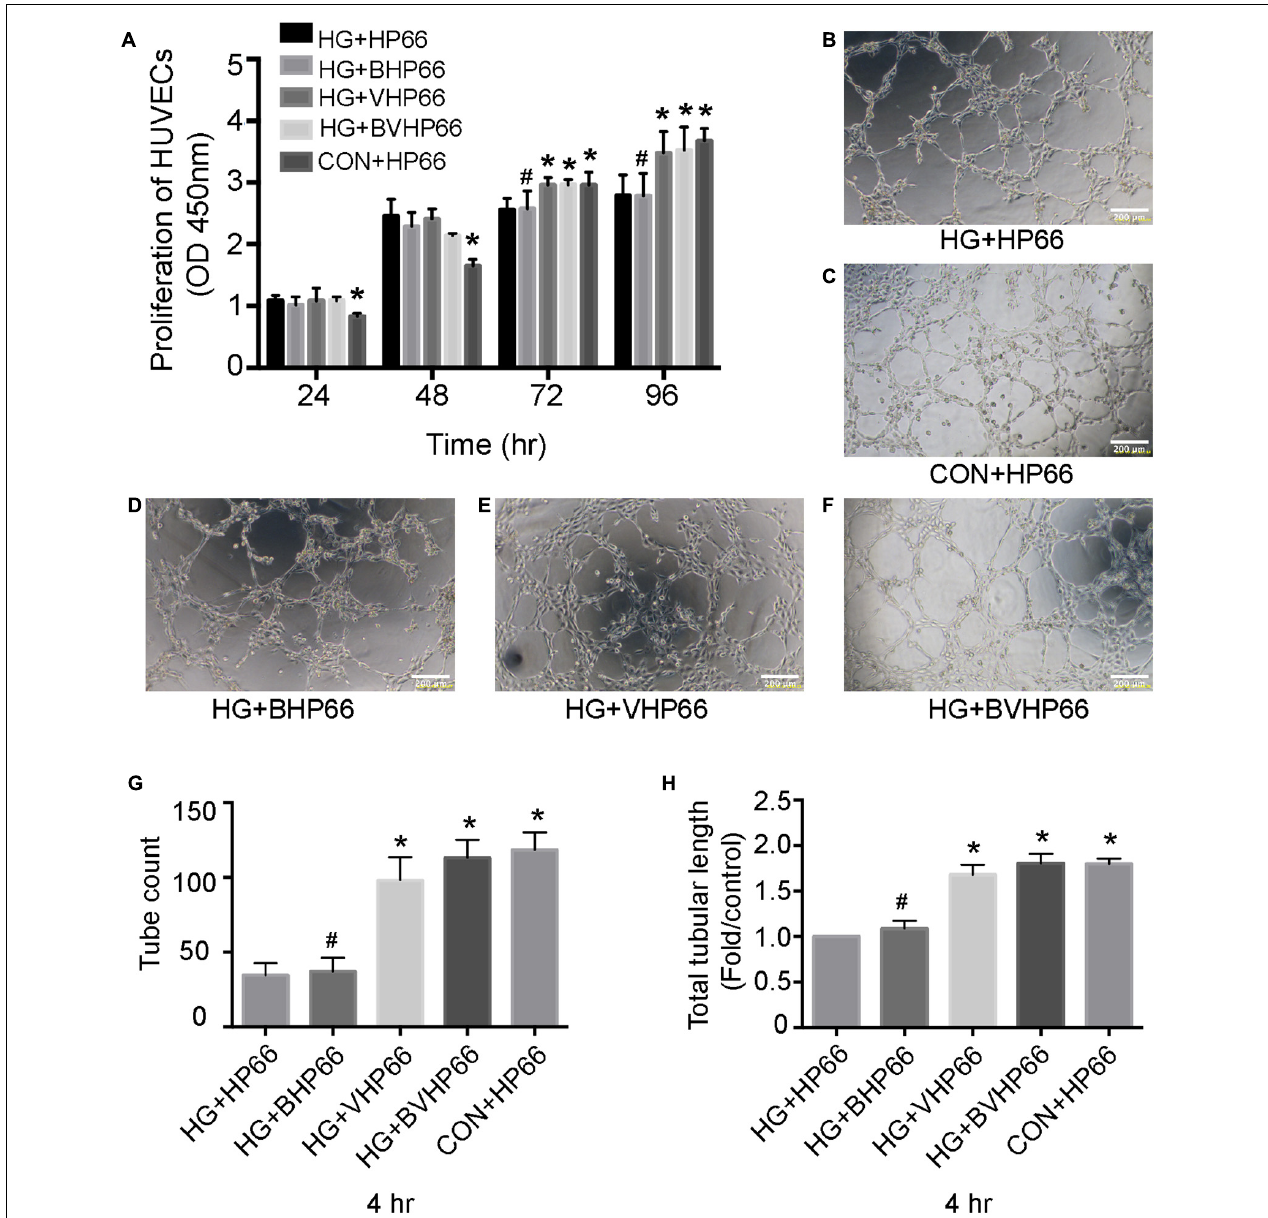
FIGURE 8 | Proliferation and tube formation of HUVECs. (A) The proliferation of HUVECs in different groups at different hours. (B–F) Representative images of tube formation after incubated for 4 h. The results of (G) tube count and (H) total tubular length. Scale bar = 200 µ m. n = 3 for each group, data were expressed as mean ± SD. * P < 0.05, vs. HG + HP66 group; # P < 0.05, vs. HG + BVHP66